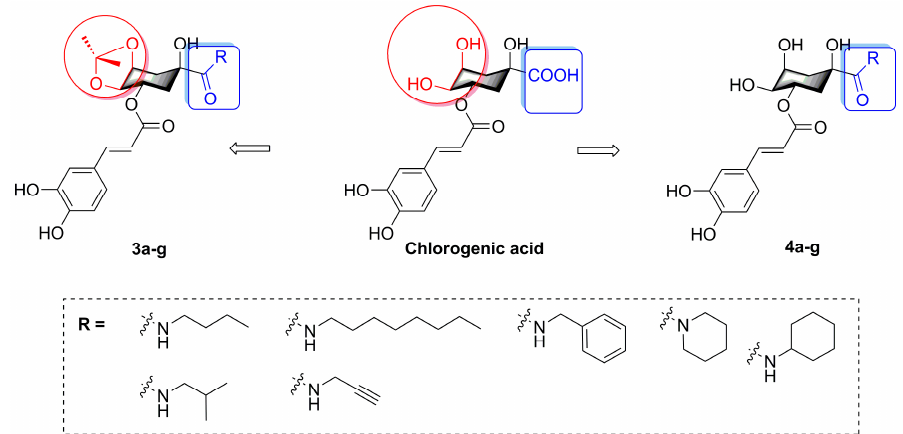
Figure 2. The structures of chlorogenic acid derivatives.